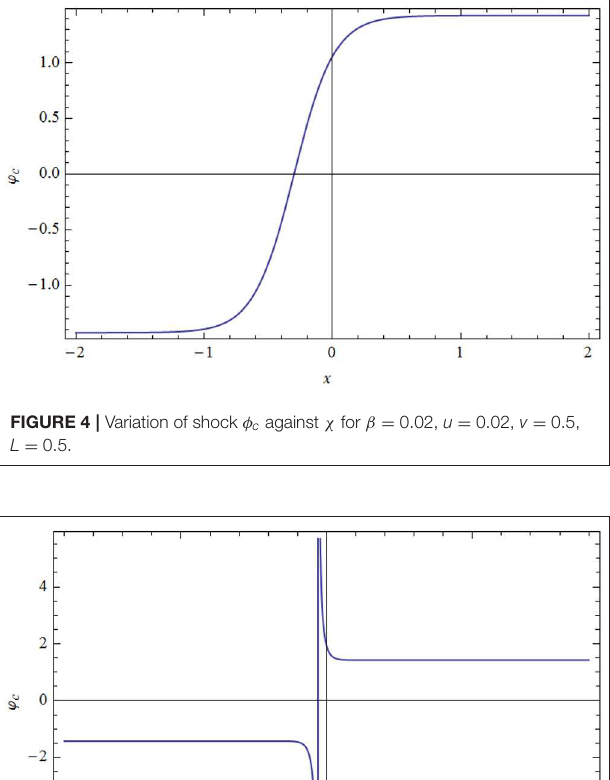
FIGURE 2 | Variation of rational φ c against χ , β for u L 0.95. =